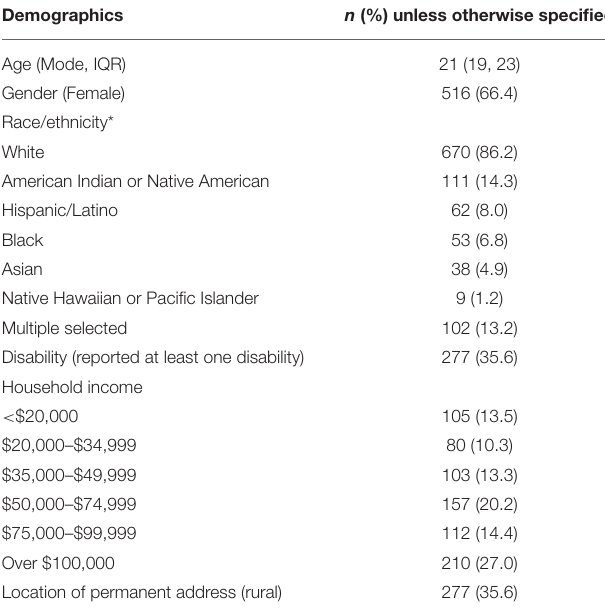
TABLE 1 | Sample characteristics ( N =